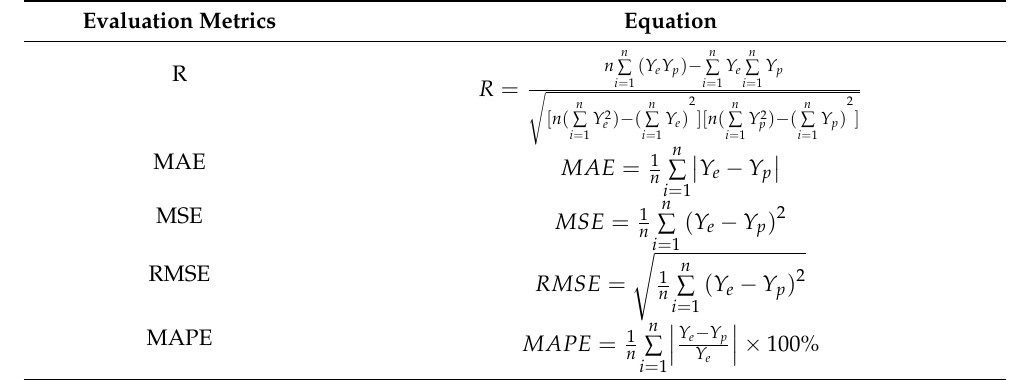
Table 2. Equations of the evaluation indices.